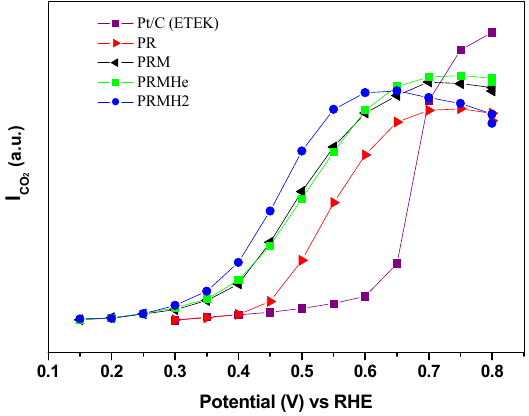
Figure 6. Integrated intensities of the CO band for the three ternary catalysts, the home 2 made binary catalyst and the commercial monometallic catalyst 20% Pt/C (ETEK). Adapted from Tsiouvaras et al.